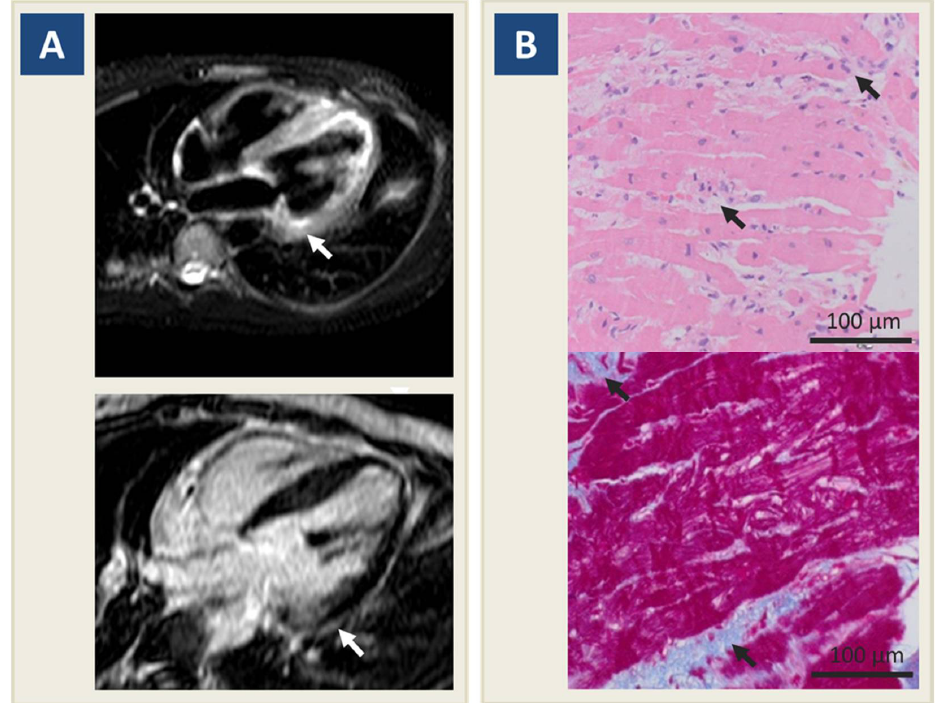
Figure 1. Diagnostic work-up for myocarditis. Legend. ( A ) Cardiac magnetic resonance shows hyperintensity in T2-weighted sequences in basal lateral left ventricular wall (upper panel, arrow) and subepicardial late gadolinium enhancement at the same site (lower panel, arrow). ( B ) Endomyocardial biopsy shows lymphomonocytic inflammatory infiltrates (upper panel, arrows), focal myocyte necrosis, and interstitial edema at hematoxylin eosin assay, associated with spotty replacement fibrosis (lower panel, arrows) at trichrome assay.